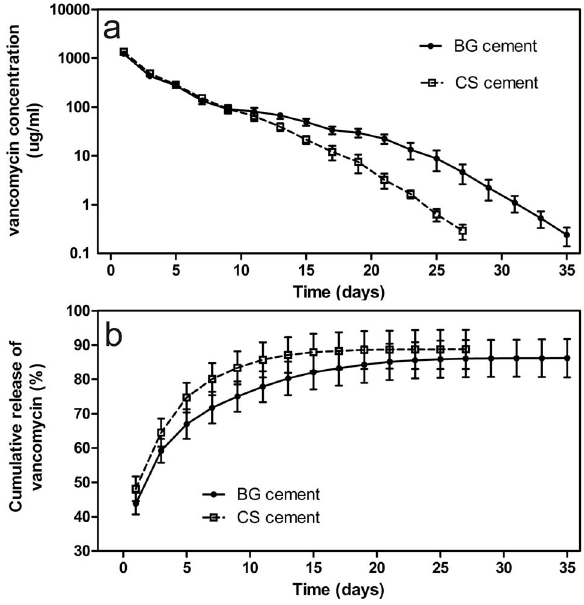
Figure 4. Vancomycin release profile in vitro. (a) Concentration of vancomycin released from borate BG cement and calcium sulfate (CS) cement into PBS at different time points; (b) cumulative amount of vancomycin released (as a percentage of the amount initially loaded into the cements) as a function of immersion time in PBS.